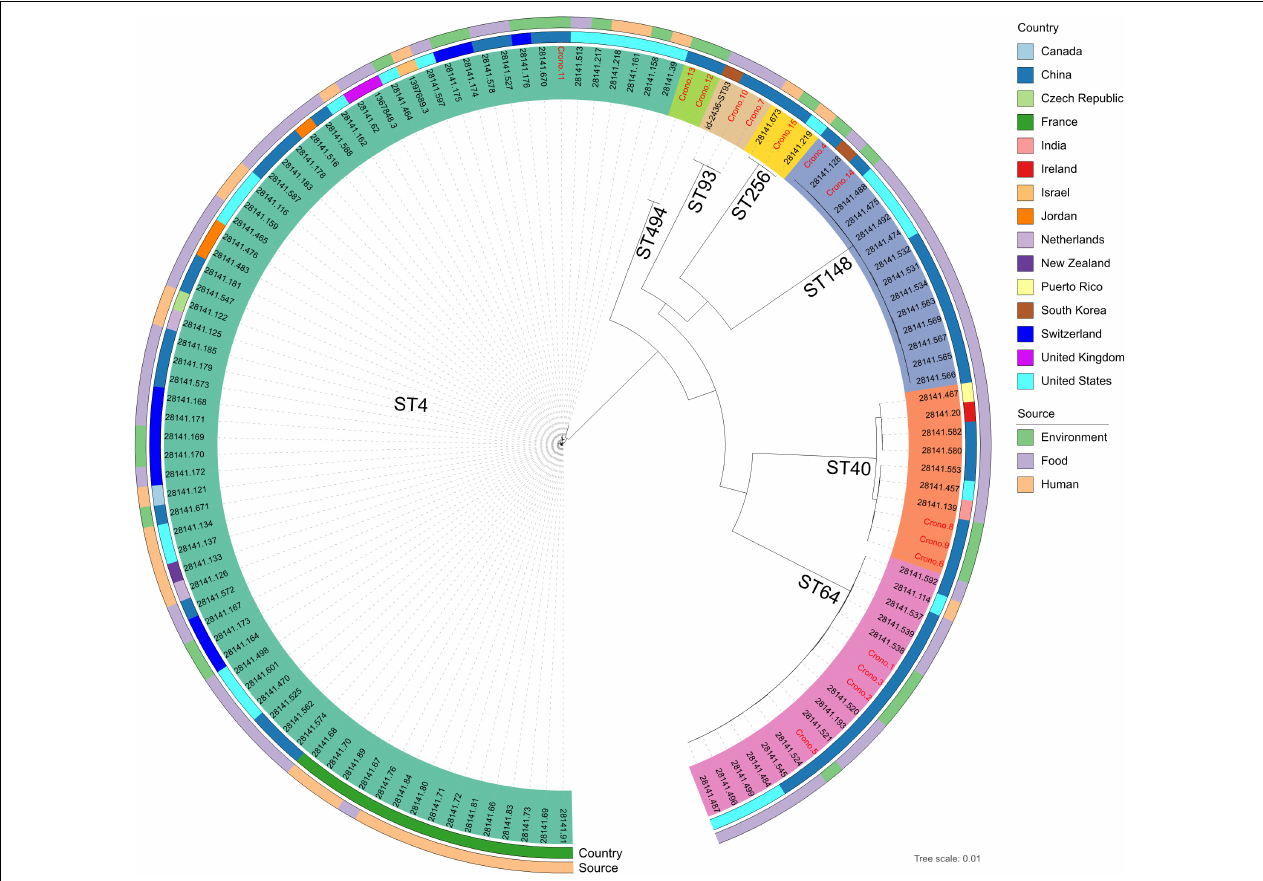
FIGURE 3 | Whole-genome maximum likelihood phylogenetic trees of all 15 C. sakazakii genomes in this study combined with 108 reference genomes shared the same sequence types from PATRIC. Isolates that were clustered with the same color-coded label background shared the same sequence type, as marked on each clade. The ID font of genomes in this study and reference genomes were distinguished in red and black, respectively. The isolation information of countries and sources were also color-coded in the following